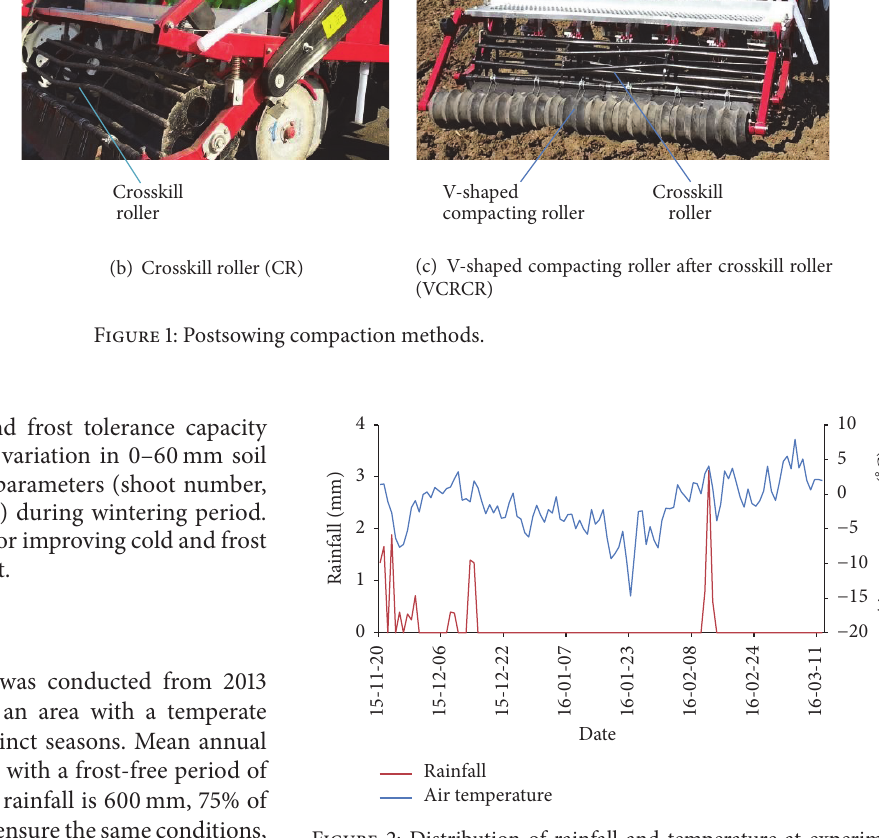
Figure 2: Distribution of rainfall and temperature at experiment